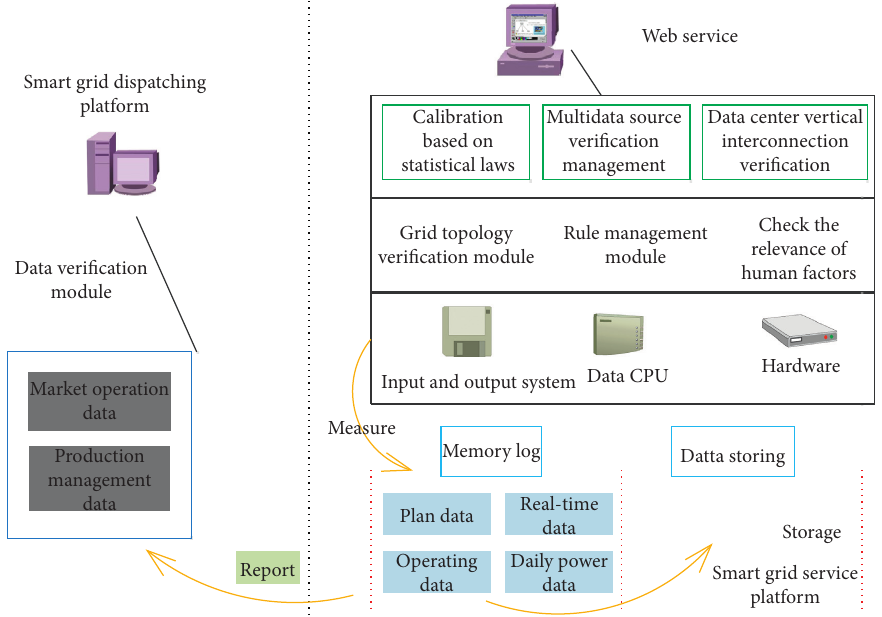
Figure 3: Schematic diagram of data verification in power dispatch data